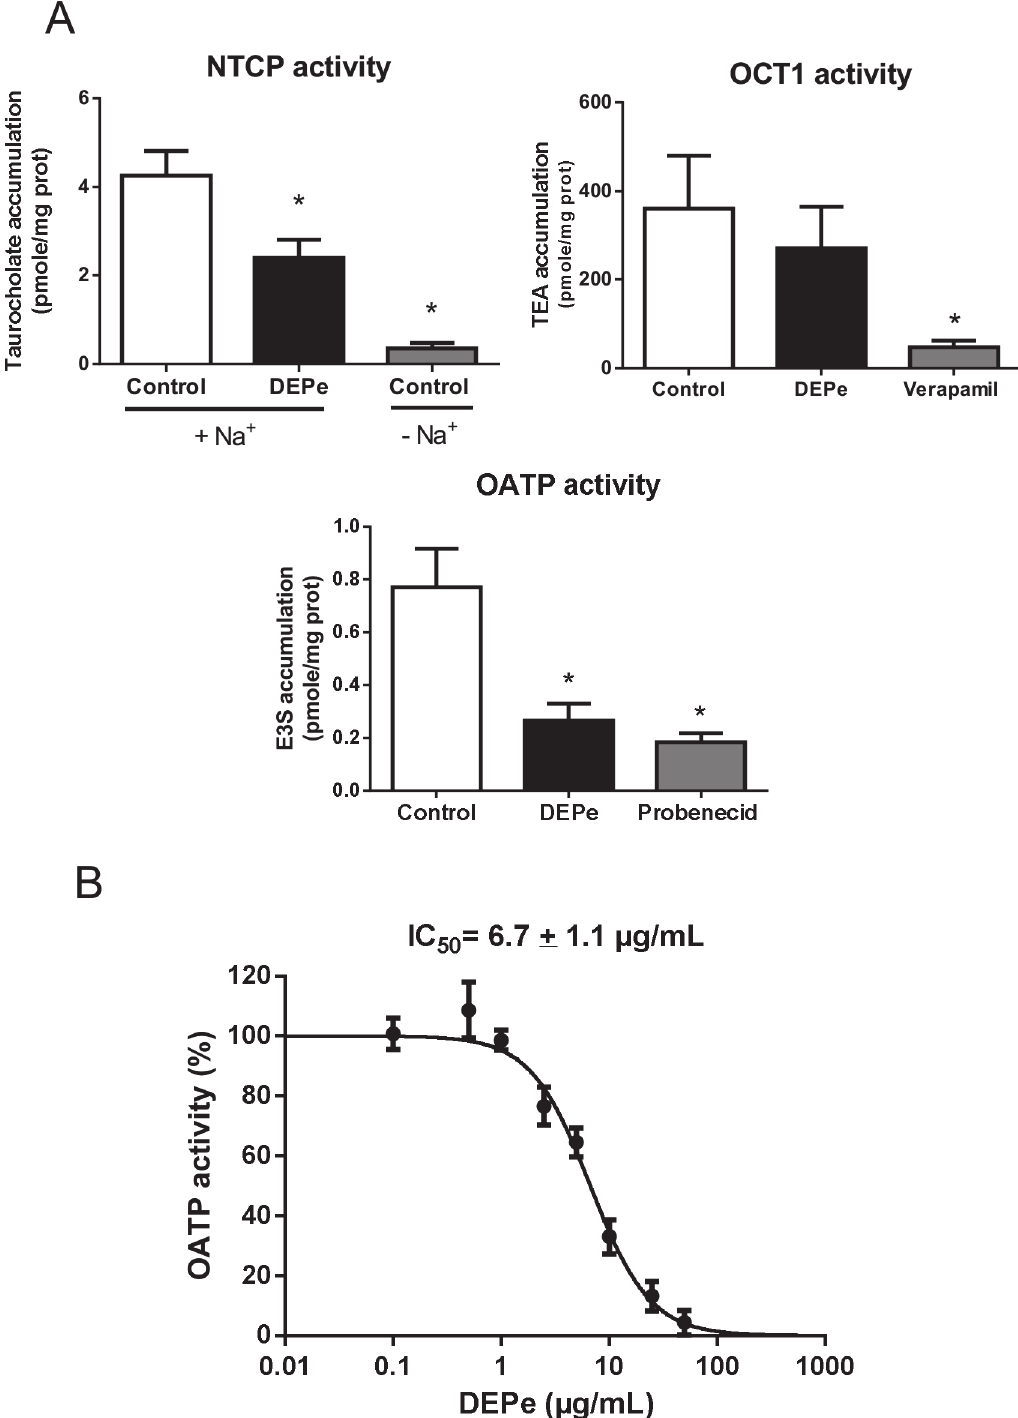
Fig 1. Effects of DEPe on NTCP, OATP and OCT1 transport activity in primary human hepatocytes. (A) NTCP-mediated uptake of taurocholate, OATPs-mediated uptake of E3S and OCT1-mediated uptake of TEA in primary human hepatocytes were determined in the absence or presence of 25 μ g/mL DEPe as reported in the Material and Methods. Reference inhibition of NTCP, OATP and OCT1 activity was obtained in parallel through withdrawal of sodium (NTCP inhibition) or addition of 2 mM probenecid (OATP inhibition) or of 50 μ M verapamil (OCT1 inhibition). Data are expressed as substrate accumulation/ mg protein and are the means ± SEM of at least three independent experiments. * , p < 0.05 when compared to control cells (ANOVA followed by a Dunnett ’ s post-hoc test). (B) OATPs-mediated transport of E3S was measured in the absence or presence of various concentrations of DEPe (from 0.1 to 50 μ g/mL) or